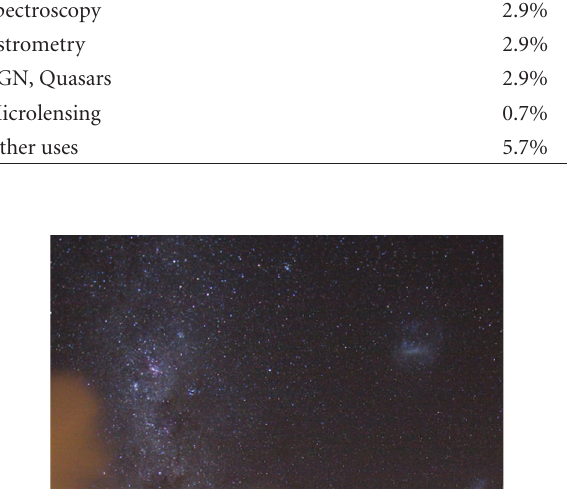
How are RAOs distributed worldwide? The number of of which nearly 80% are in Europe and in the U.S. (see